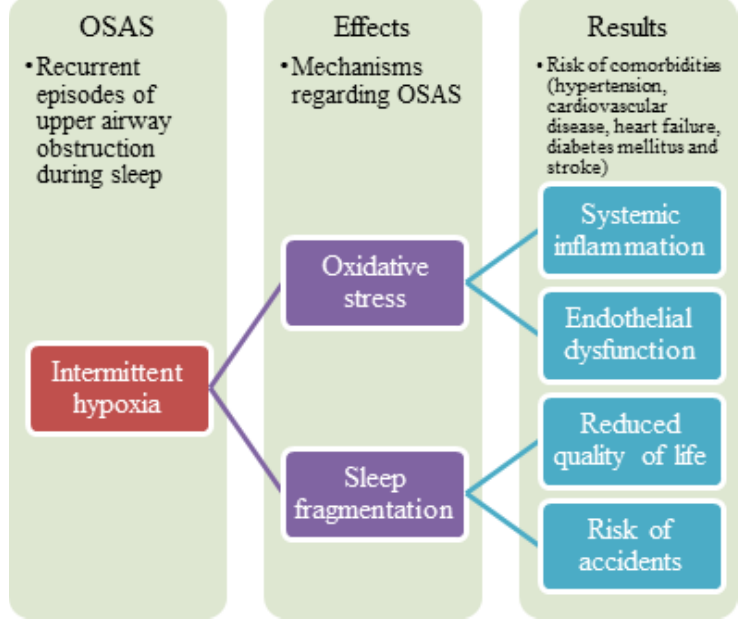
Figure 1. Summary of mechanisms regarding obstructive sleep apnea syndrome. Cardiovascular and pulmonary complications are thought to be caused by tissue injury associated with chronic intermittent hypoxia [19]. The mechanisms of these tissue injuries are not known. OSA stimulates, mainly through intermittent hypoxia, several mechanisms, including inflammation, endothelial dysfunction, and oxidative stress [20]. In intermittent hypoxia, the inflammatory signaling factors play essential roles in the transcriptional regulation of inflammatory cytokines. However, their role in OSA pathogenesis and the exact relationships between pathogenic mechanisms remain